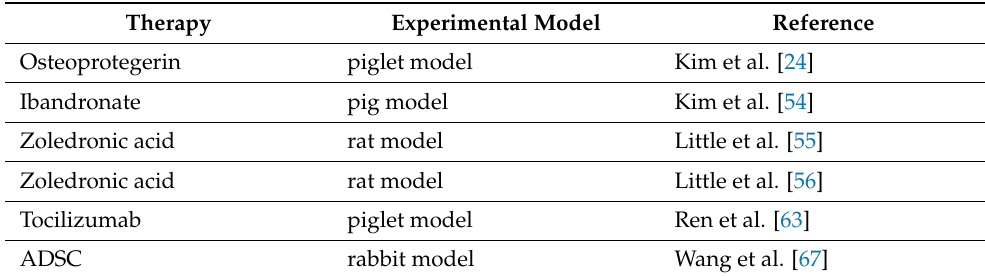
Table 2. Biological treatments of Perthes